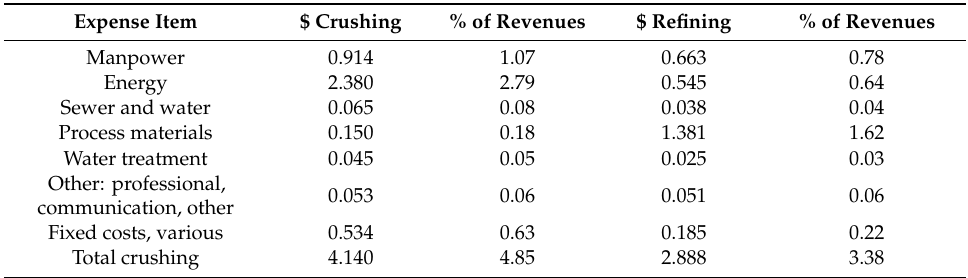
Table 5. Summary of operating costs other than depreciation and feedstock cost for the first year of production, in million dollars and as a percentage of total